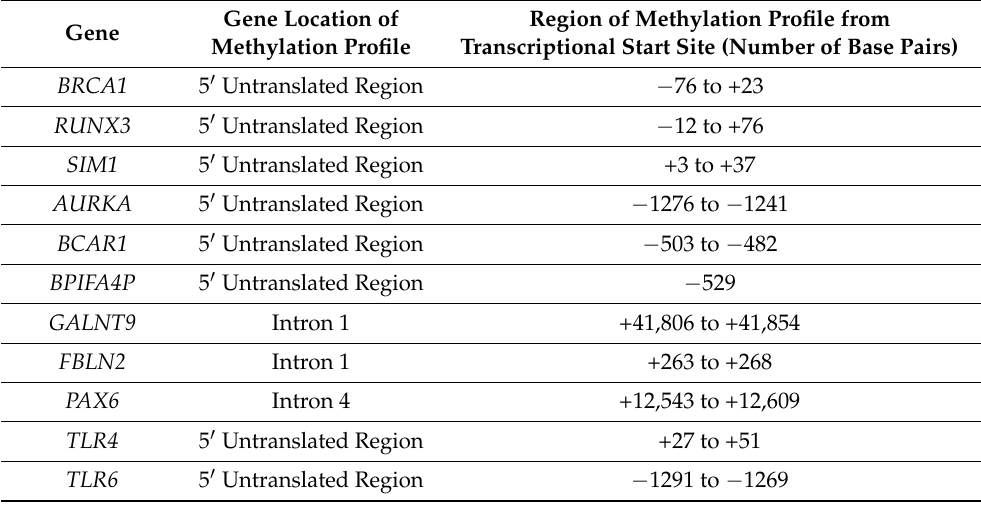
Table 4. Regions and locations of CpG site interrogated relative to respective transcriptional start site. Gene Location of Region of Methylation Profile Gene Methylation Profile